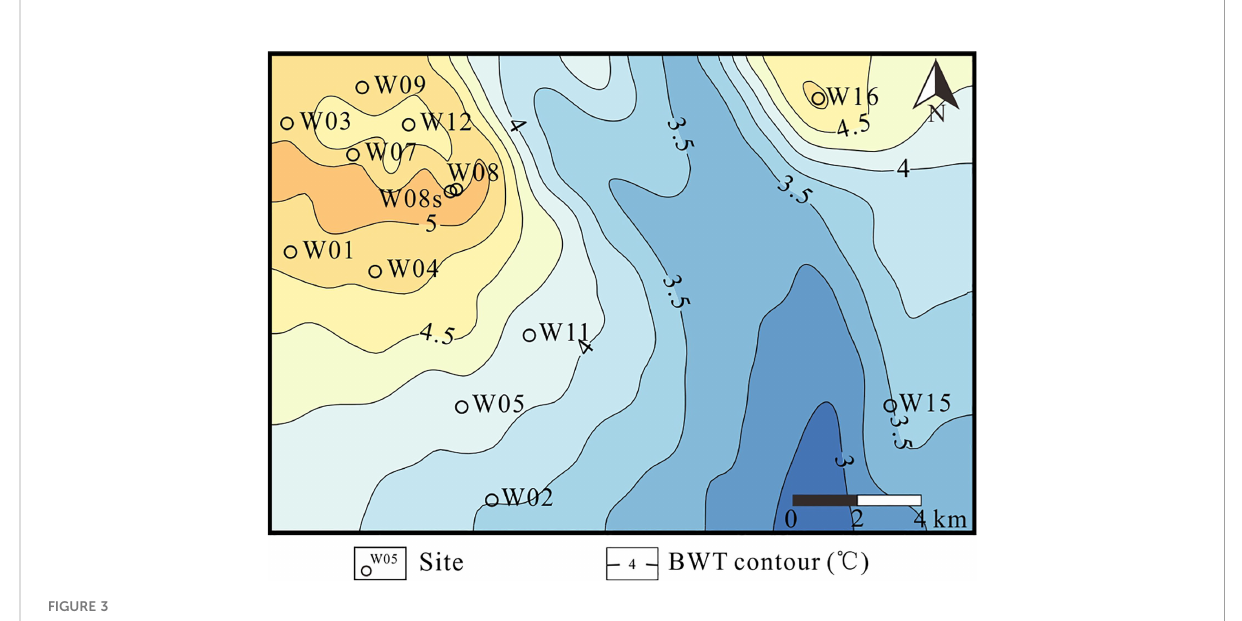
FIGURE 3 BWT characteristics in the Dongsha region, northern